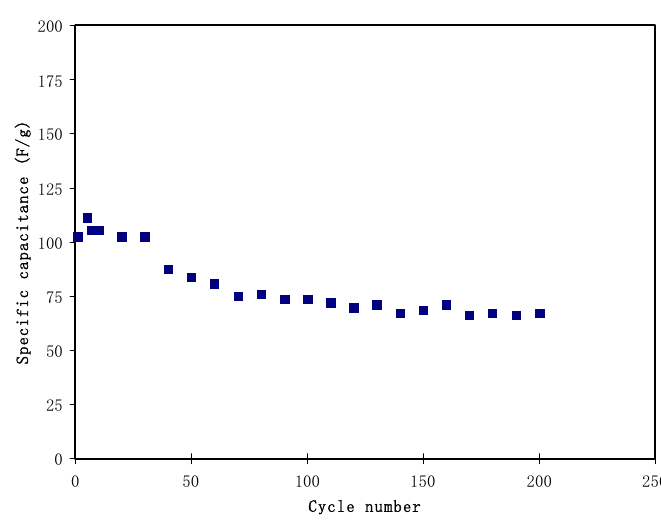
/ cm 2 for 200 complete